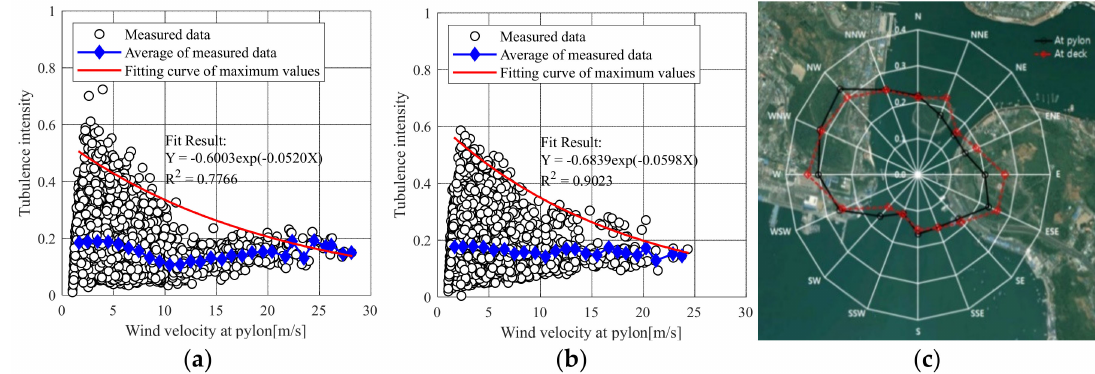
Figure 3. Turbulence intensity: ( a ) At 91 m height; ( b ) At 29 m height; ( c ) Directional turbulence